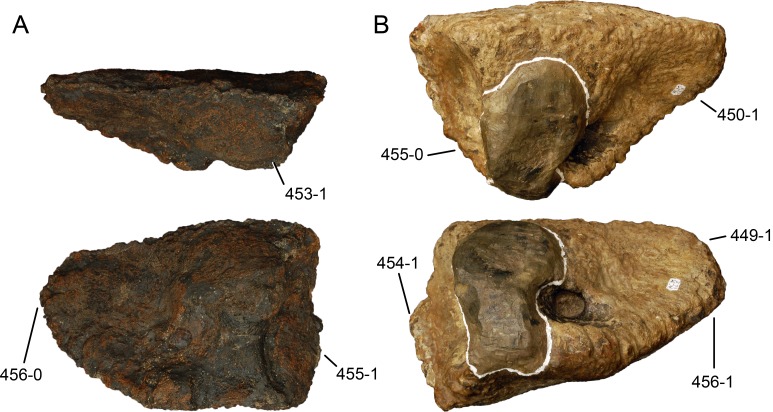
Flagellicaudatan astragali.Astragalus of SMA 0087 (A) and Dyslocosaurus polyonychius AC 663 (B) in dorsal (top) and posterior (bottom) view. Note the triangular shape in both views (B; C449-1, C450-1), the ascending process that reaches the posterior border (A; C453-1), the anterior border of the fibular facet, which is visible in posterior view (B; C454-1), the presence (B; C455-0) or absence (A; 455-1) of a sheet underlying the fibula, and the blunt (A; C456-0) in contrast to elongate medial end (B; C456-1). Scaled to the same proximodistal height.